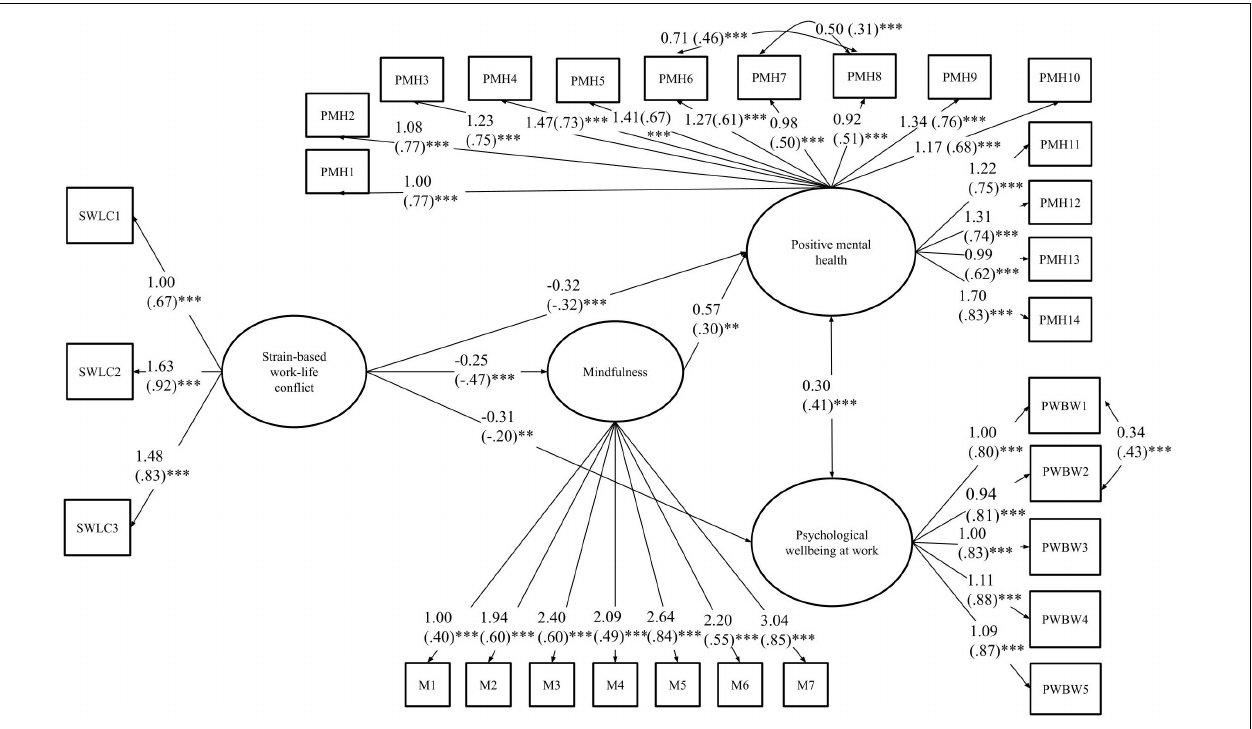
FIGURE 2 | The (in)direct effect of strain-based WLC on positive mental health and psychological wellbeing at work. The figure includes the unstandardized estimates accompanied by standardized estimates in brackets. Only significant links between core study variables are shown in the figure. Control variables described in the methods section were also included, but not represented to facilitate ease of reading. ∗ p < 0.05, ∗∗ p < 0.01, ∗∗∗ p < 0.001.